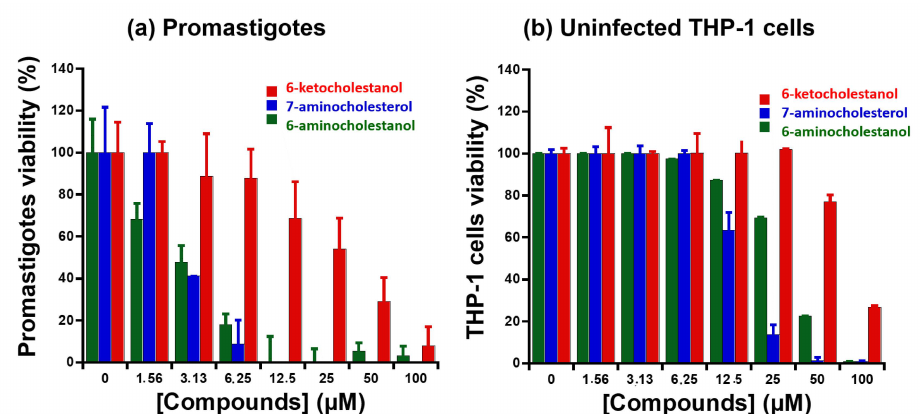
Figure 4. MTT cell viability assay shows a promising anti-leishmanial activity of the cholestanol and sterol derivatives in a dose-dependent manner and a little cellular toxicity at the active concentrations. ( a ) Effects on L. infantum promastigotes. ( b ) Effects on uninfected THP-1-derived macrophages. The cholesterol was not active at the tested